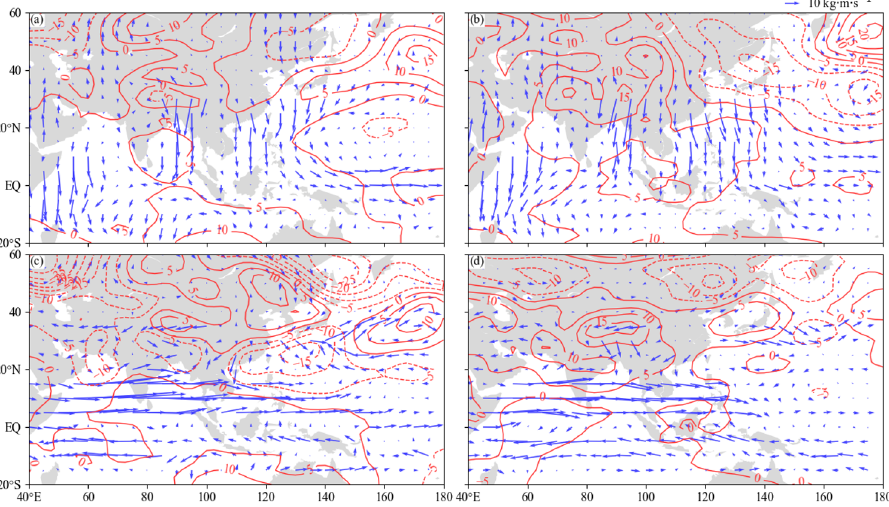
Figure 4. Difference of 850 hPa geopotential height field (red contours, unit: gpm), integrated water vapor flux (blue vector, unit: kg · m · s − 1 ) between four PDO&IOD phase combinations in the preflood season over South China during 1960–2012 (( a , b ) for the frontal precipitation, ( c , d ) for the monsoon precipitation; ( a , c ) for PDO positive phase &IOD positive phase minus PDO positive phase &IOD negative phase, ( b , d ) for PDO negative phase &IOD positive phase minus PDO negative phase &IOD negative phase).